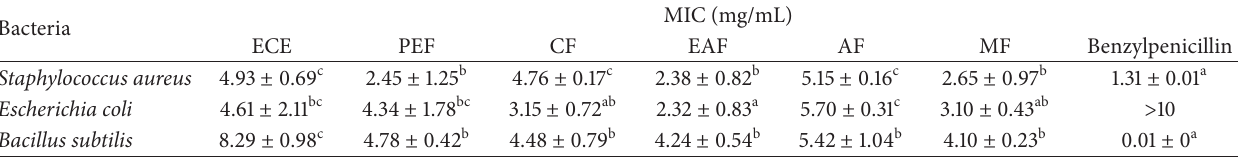
Table 7: MIC values of ethanol extracts and its five fractions from Z. bungeanum leaves against 3 selected bacteria. Bacteria